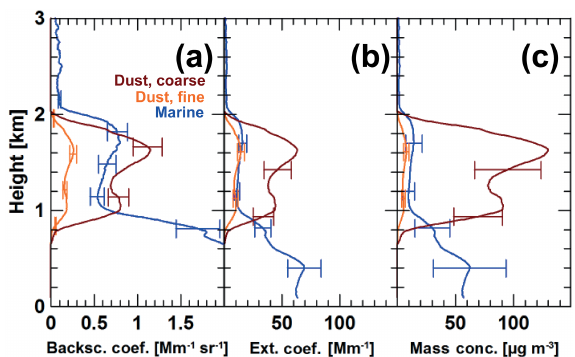
Figure 4. Solutions of the two-step POLIPHON data analysis (for case 4): (a) non-dust (blue, here for marine aerosol with lidar ra- tio of 20sr), fine-mode dust (orange), and coarse-mode dust (dark red) backscatter coefficients, (b) respective marine, fine-mode, and coarse-mode dust extinction coefficients, and (c) marine, fine-mode, and coarse-mode dust particle mass concentration. Error bars indi- cate the retrieval uncertainties (1 standard